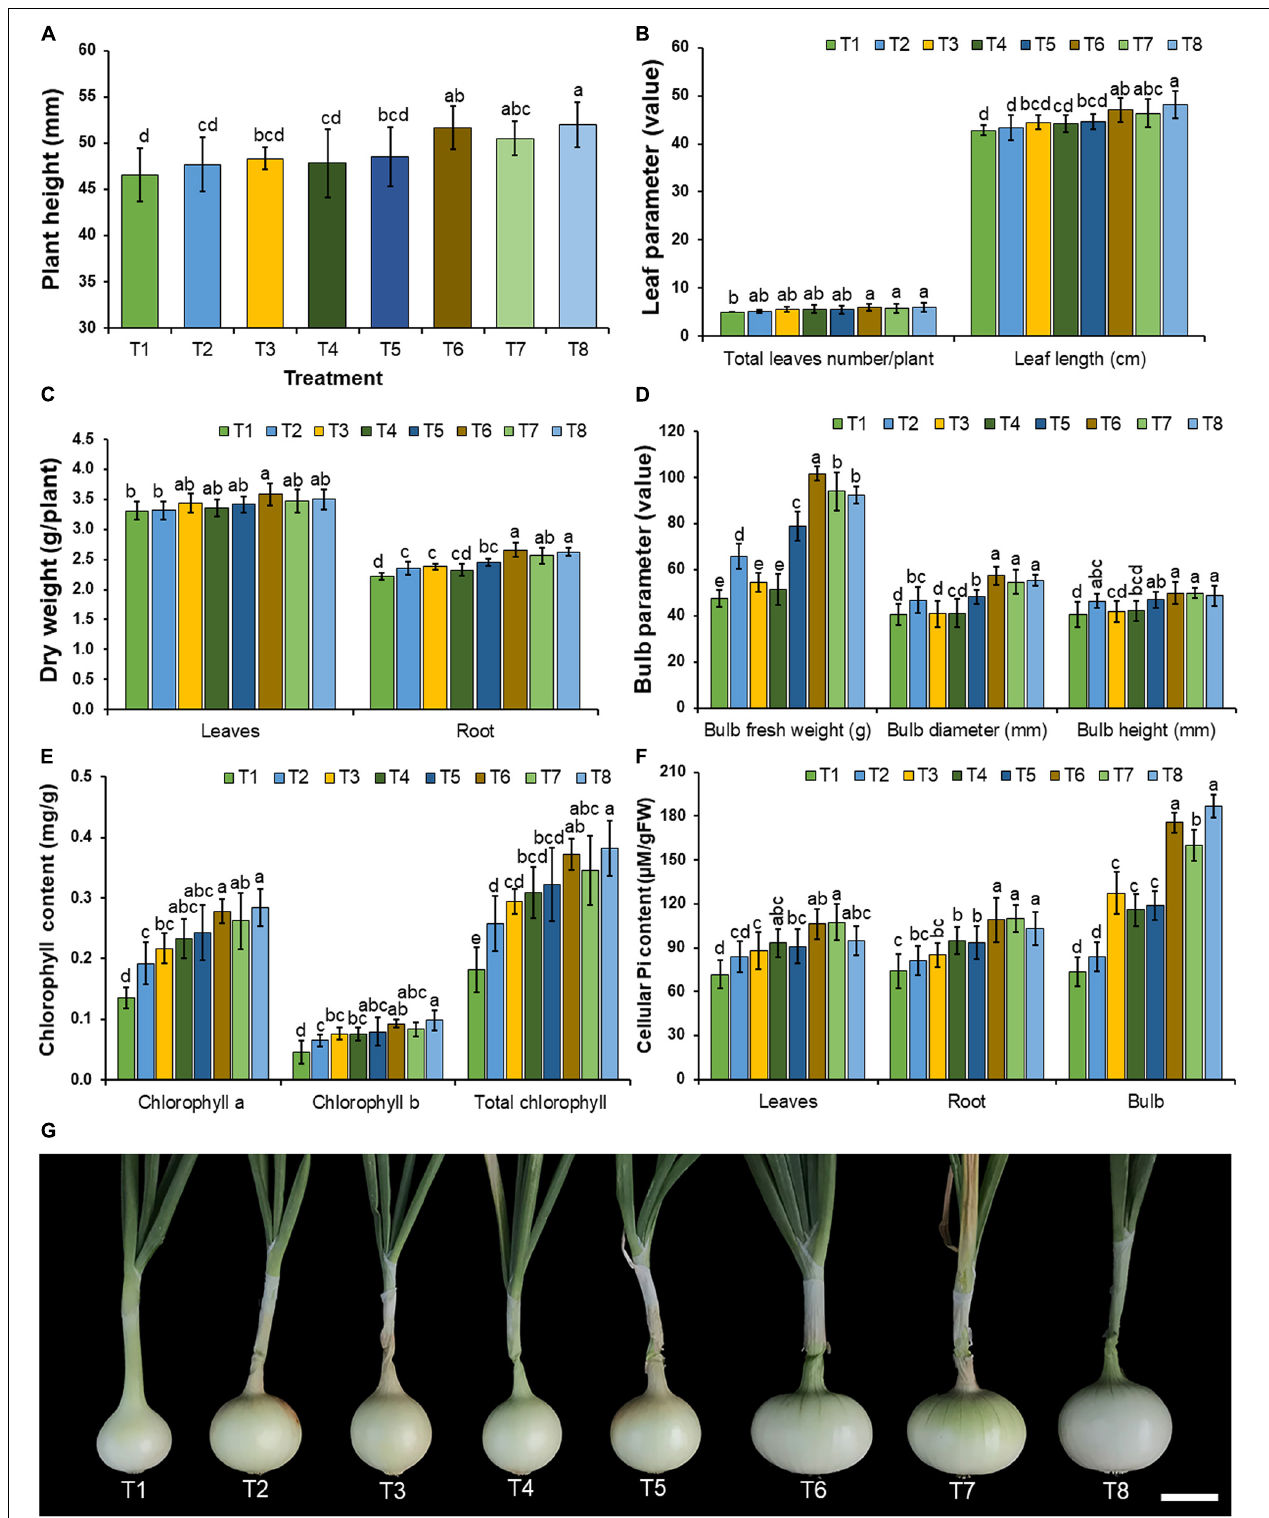
FIGURE 7 | Effect of mineral-solubilizing fungi on the growth and yield of onion. (A) Plant height, (B) total leaf number and leaf length, (C) leaves and root dry weight, (D) bulb fresh weight, bulb diameter, and bulb height, (E) chlorophyll content, (F) cellular inorganic phosphate content, (G) onion bulb in each treatment. Error bars represent the standard deviation of the mean. The different letters indicate significant difference ( p ≤ 0.05). Scale bar: (G) 2 cm.